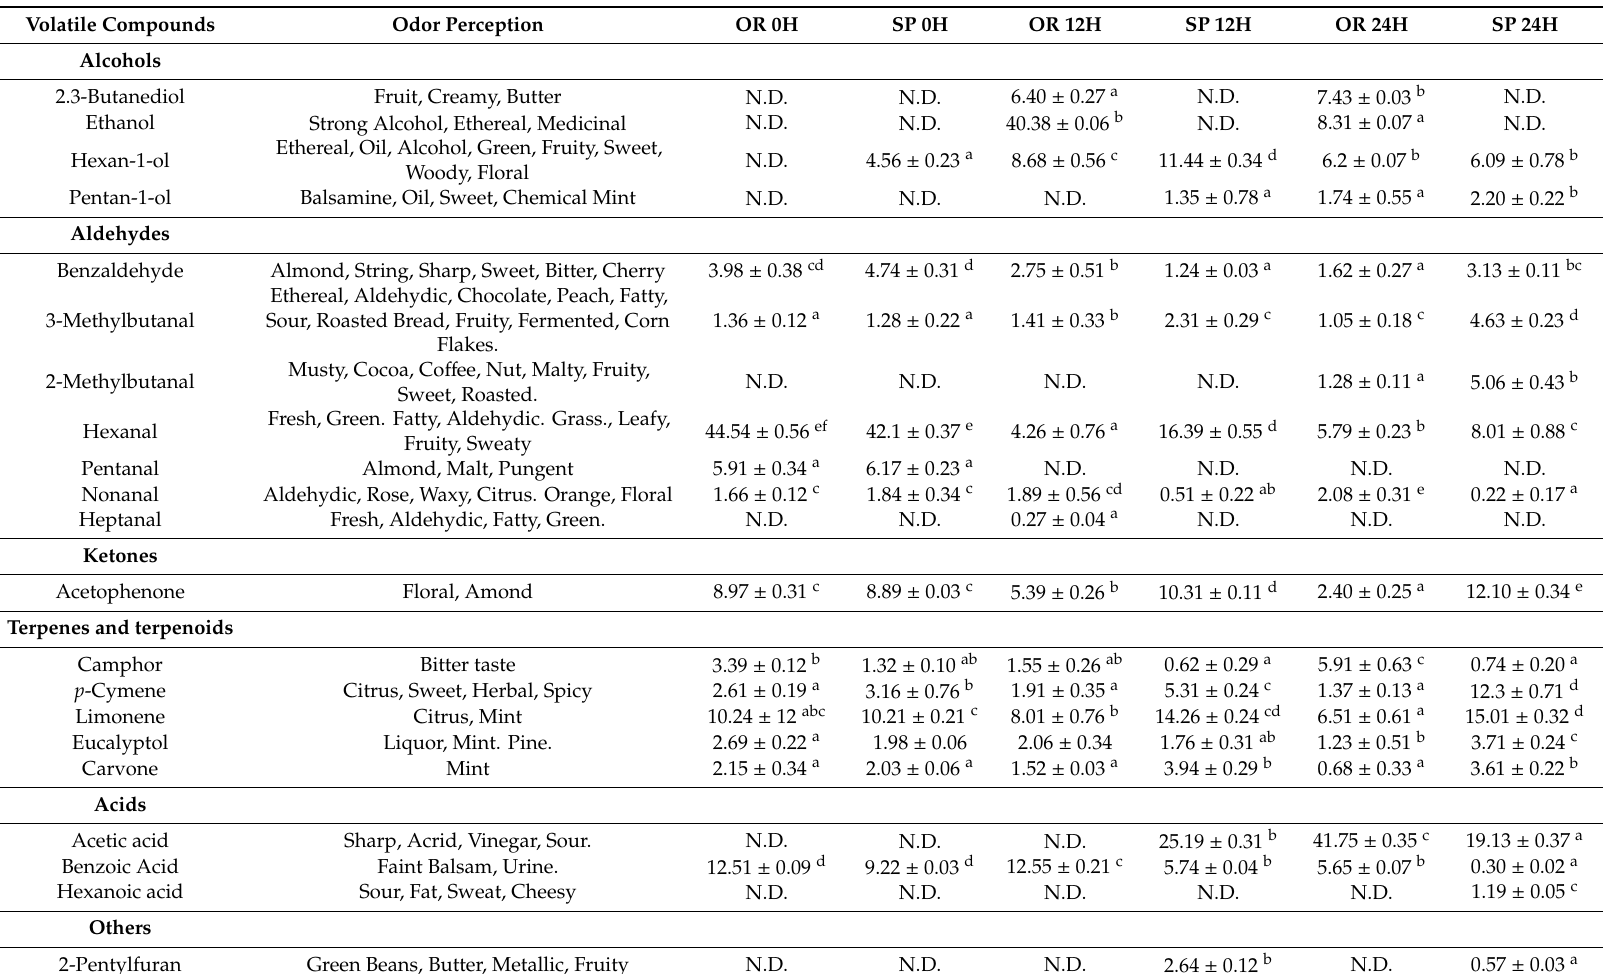
Table 6. Aroma compounds formed during 24 h of OR and SP sourdough fermentation